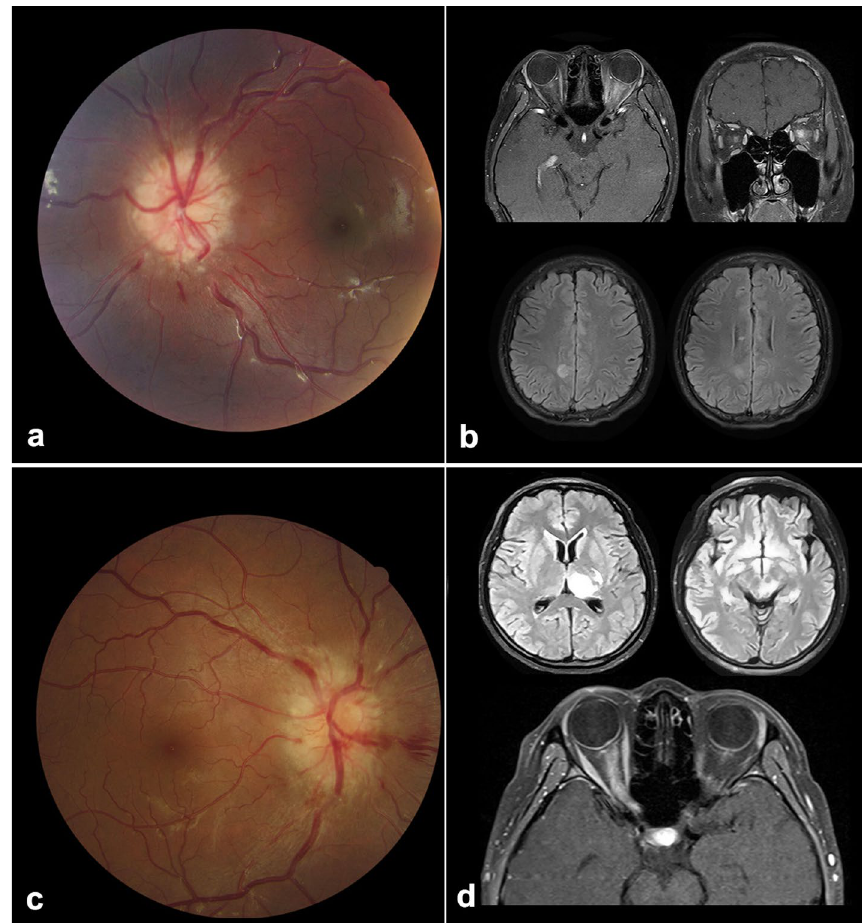
Figure 2. Patients who had a positive result for myelin oligodendrocyte glycoprotein antibodies presenting with brain lesion without diagnosis. ( a , b ) Images of a 12-year-old boy presenting with acute visual loss in the left eye for 10 days. One month ago, he experienced sudden loss of consciousness and a seizure. Fundoscopy ( a ) shows obvious edema of the optic disc, and brain and orbit magnetic resonance imaging (MRI) ( b ) shows enlarged and enhanced left optic nerve with brain lesions, indicating acute disseminated encephalomyelitis-like demyelinating disease, which was the probable cause for the seizure. ( c , d ) Images of a 30-year-old woman presenting with acute visual decrease in the right eye for 2 weeks. One month ago, she complained of weakness in her right body, while brain MRI showed a midbrain lesion, which recovered spontaneously. Fundoscopy ( c ) shows a severe swelling of the optic disc, and orbit MRI ( d ) shows extensive enhancement of the